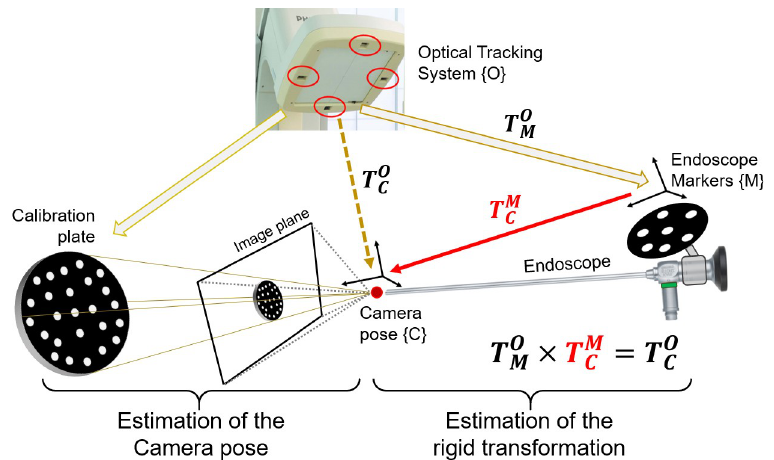
Fig 2. Experimental setup for the study on the skull